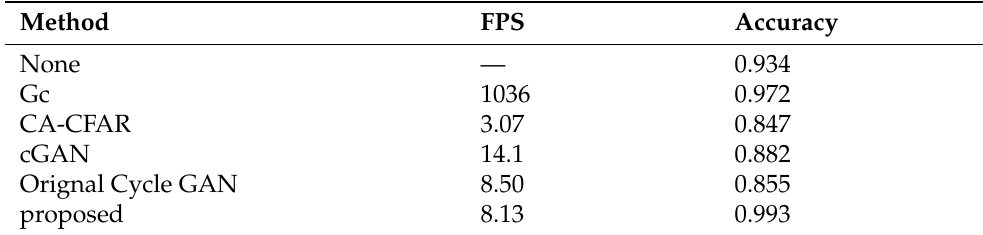
Table 7. Processing speeds and classification results of different de-wiring